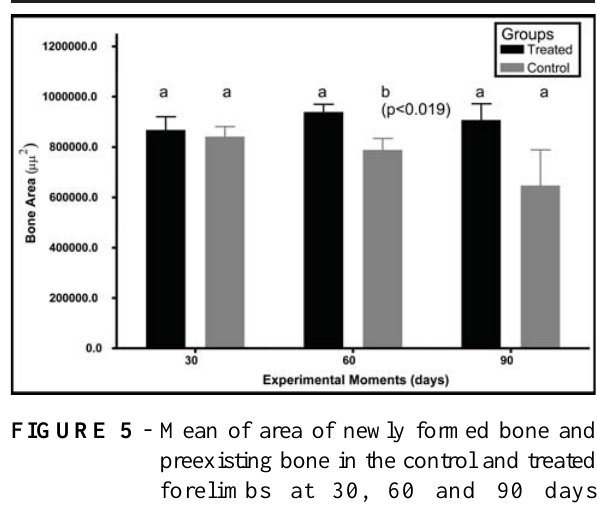
FIGURE 5 - Mean of area of newly formed bone and preexisting bone in the control and treated forelimbs at 30, 60 and 90